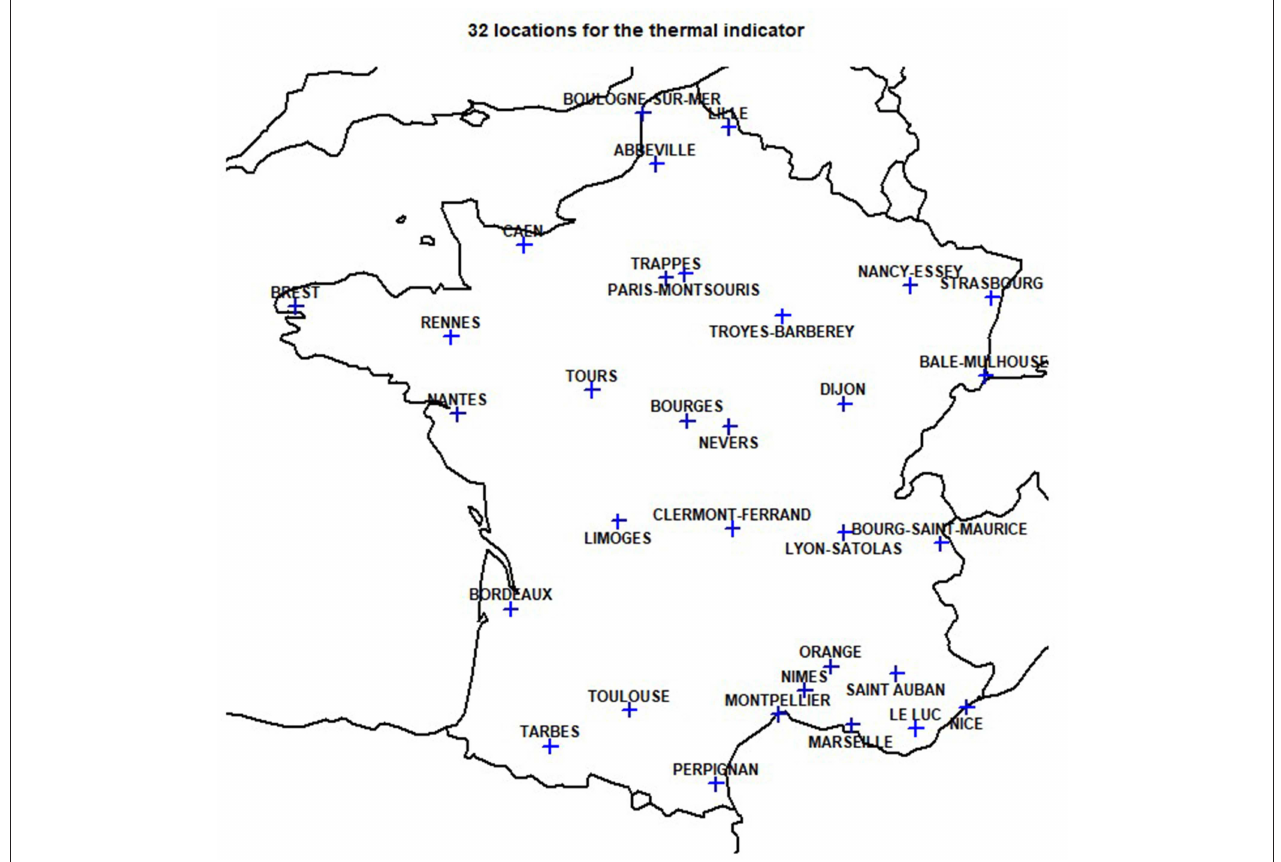
FIGURE 1 | Location of the 32 weather stations used to compute the thermal indicator for the electricity demand in France.